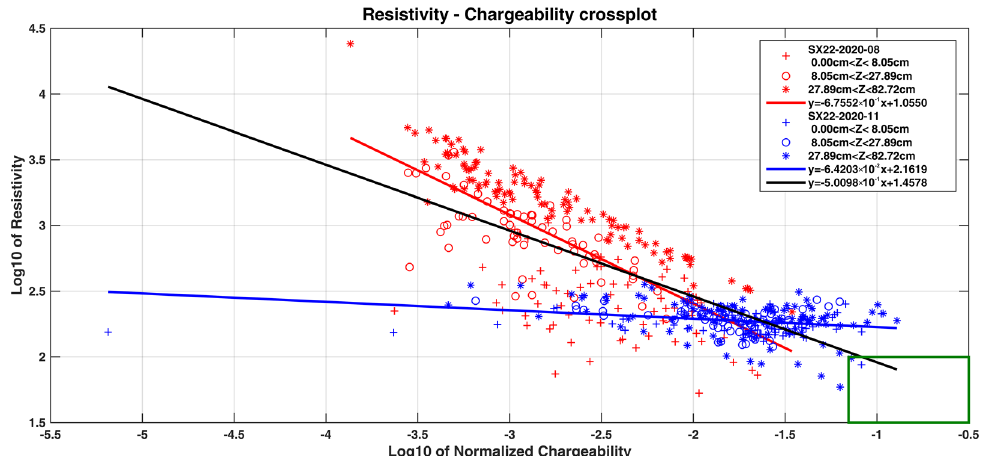
Figure 4. Log 10 –log 10 diagram of normalized chargeability and resistivity values from the geoelec- trical sections data of site #22 acquired at wet (blue) and dry (red) periods. The crosses, circles and stars correspond to the three depth zones, respectively. Blue and red lines correspond to the linear regression of wet and dry period data, respectively, while the black one corresponds to the total data from both periods.